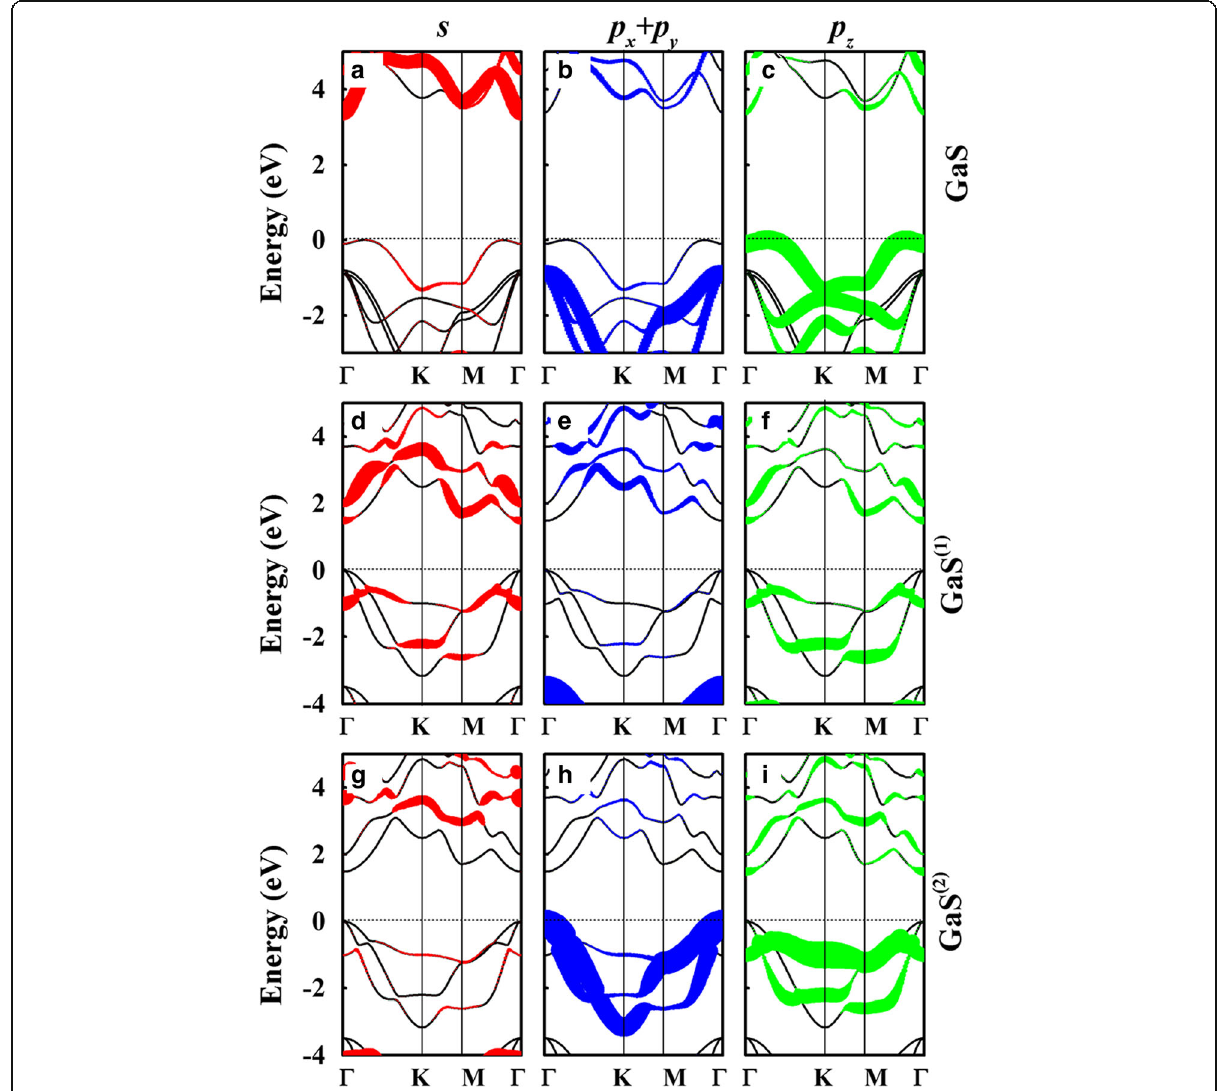
Fig. 4 The decomposed projected band structure of the GaS ML. The top panel represent the s ( a ), p x + p y ( b ) , and p z ( c ) orbits without an external electric field; the middle and last panels present the contributions of s ( d , g ), p x + p y ( e , h ), and p z ( f , i ) orbits from the upper and lower interlayer of GaS with an external electric field of 8 V/nm,